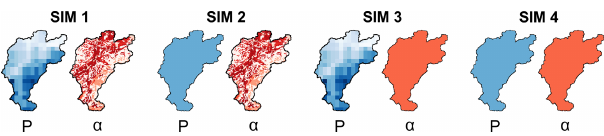
Figure 4. Summary of model runs: in SIM 1 sediment mobilization and transfer are driven by a spatially distributed precipitation ( P ) and surface erodibility ( α ); in SIM 2 and SIM 3 the spatial vari- ability in precipitation and surface erodibility have been removed, respectively; and in SIM 4 both spatial variabilities have been re-